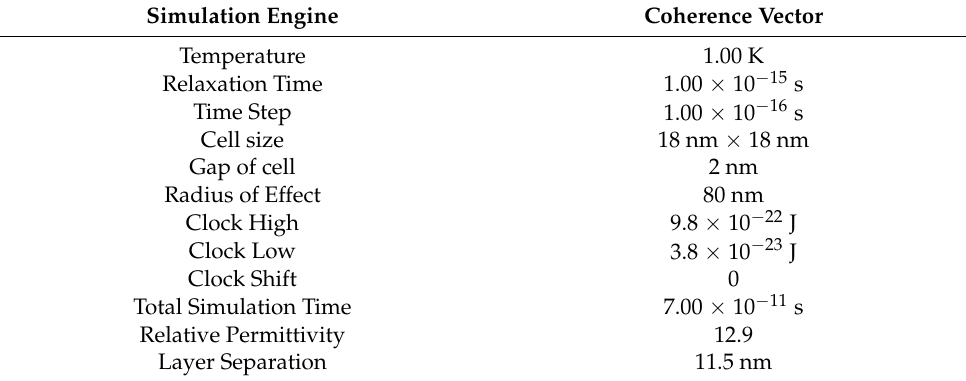
Figure 5. Proposed XOR/XNOR gates. ( a )The first XOR gate (XOR1), ( b ) the first XNOR gate (XNOR1), ( c ) the second XOR gate (XOR2), ( d ) the second XNOR gate (XNOR2), ( e ) the I/O access method for the first design, ( f ) the I/O access method for the second design and ( g ) the I/O access method for the second design. Table 2. The default parameters for the coherence vector simulation engine in QCA